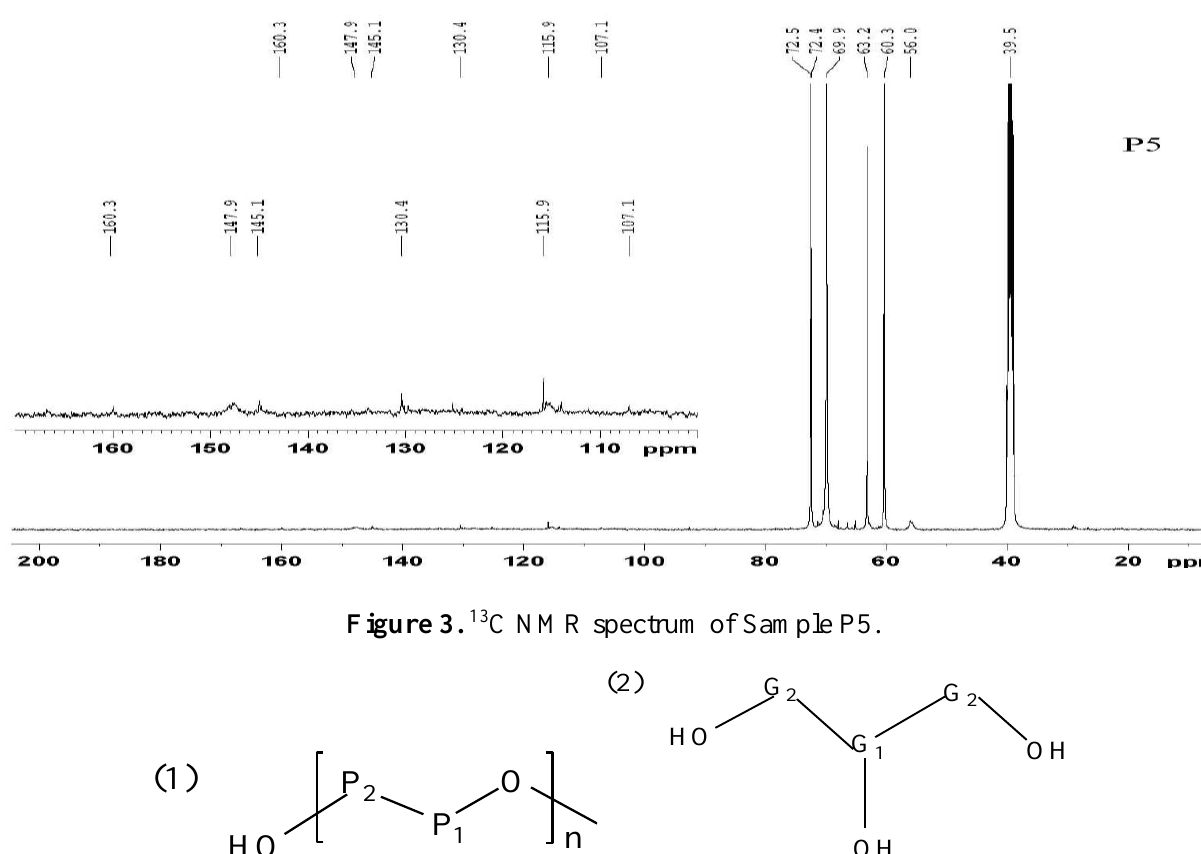
Figure 4. Structure nomenclature for NMR assignments of (1) PEG-400 and (2)